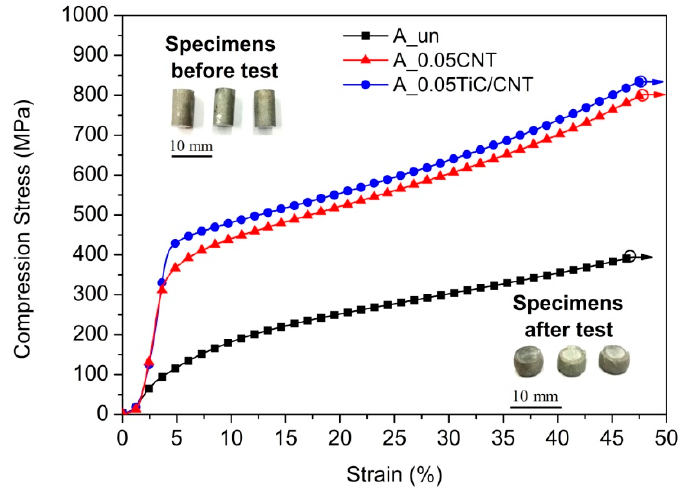
Figure 10. Typical compression stress–strain curves of different bulk AA5049-based materials. The insets show photographs of bulk specimens for compression tests before and after tests.